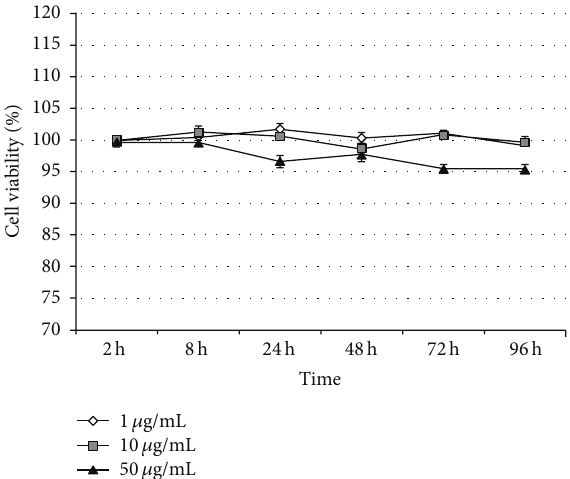
Figure 2: Effects of a bioactive compound SA isolated from D. crassirhizoma on C. idella head kidney macrophages (CIHKM) cells viability measured by MTT assay after 2, 8, 24, 48, 72, and 96 h incubation at 28 ∘ C. Bars represent the mean ± S.E.M ( 𝑛 = 3